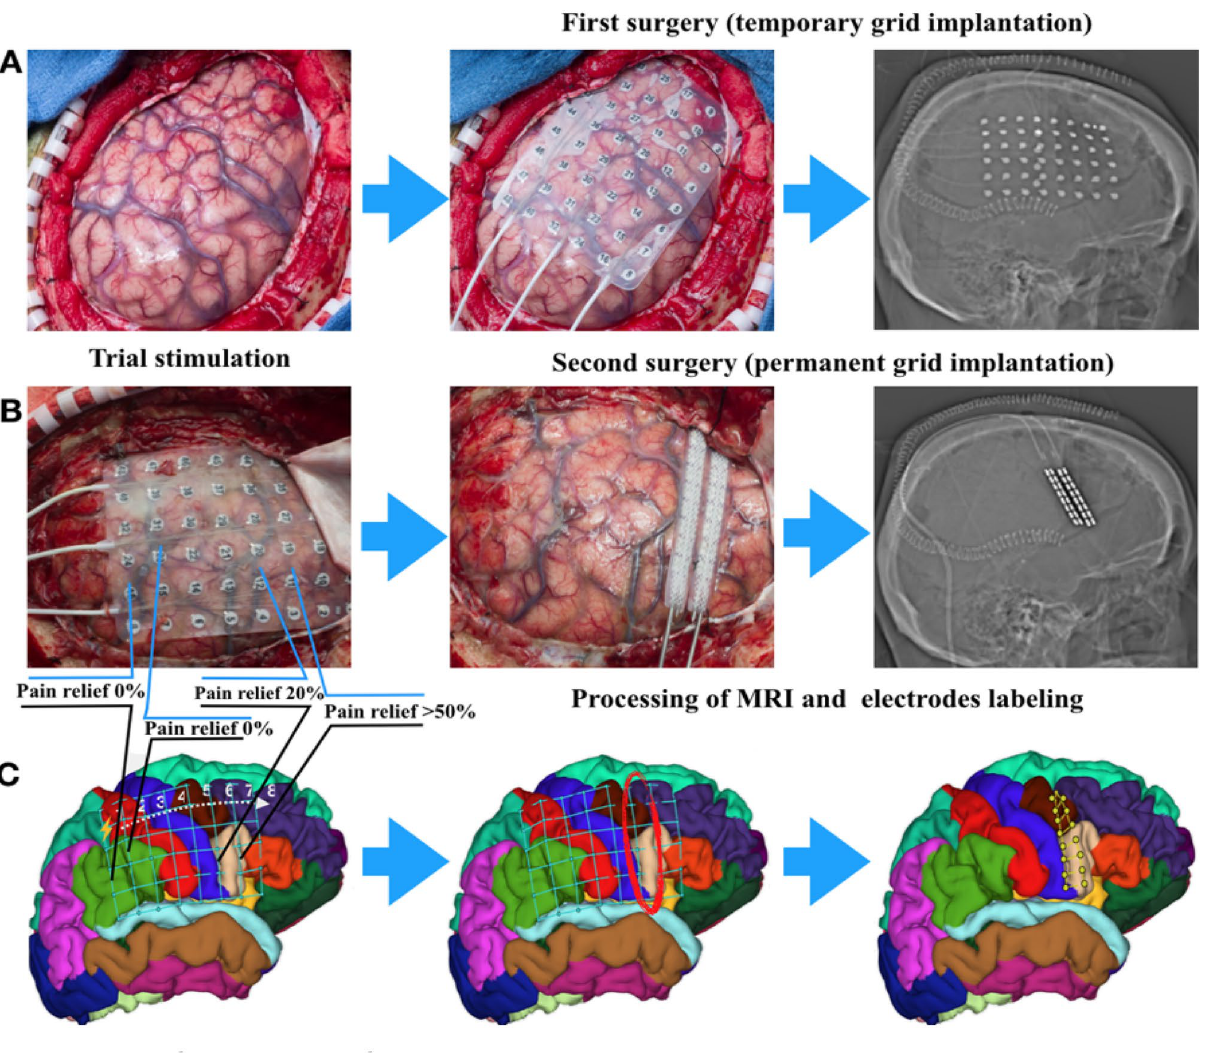
Figure 1. Surgical intervention and mapping. ( A ) Surgery for temporary grid placement in order: craniotomy; 6 × 8 temporary grid placement; X-ray/CT-scan representative for temporary grid position. ( B ) Trial stimulation for target optimization, with following permanent grid implantation over identified area. X-ray/CT-scan representative for permanent grid position. ( C ) Further image processing to reveal electrodes position over exact cortex area according to Desican-Killiany